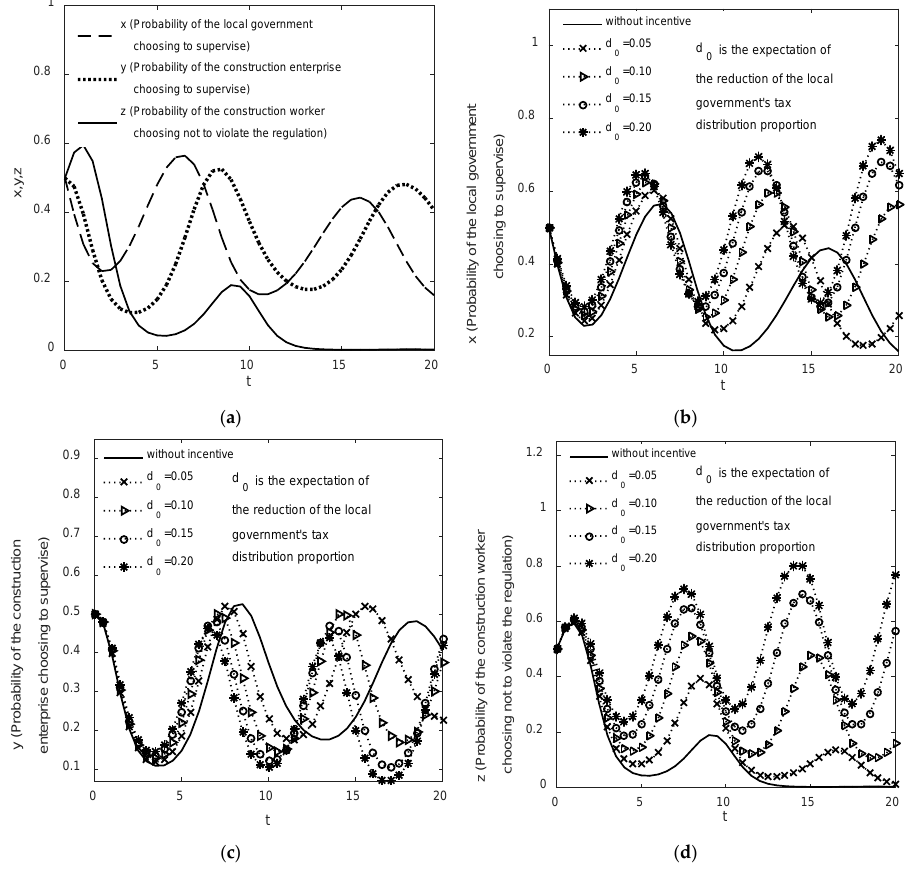
Figure 7. The impact of the tax mechanism that encourages the local government to supervise on the behavior evolution process: ( a ) evolution process without tax incentive mechanism; ( b ) the behavior evolution process of a local government under different tax incentive mechanisms; ( c ) the behavior evolution process of a construction enterprise under different tax incentive mechanisms; ( d ) the behavior evolution process of a construction worker under different tax incentive mechanisms.